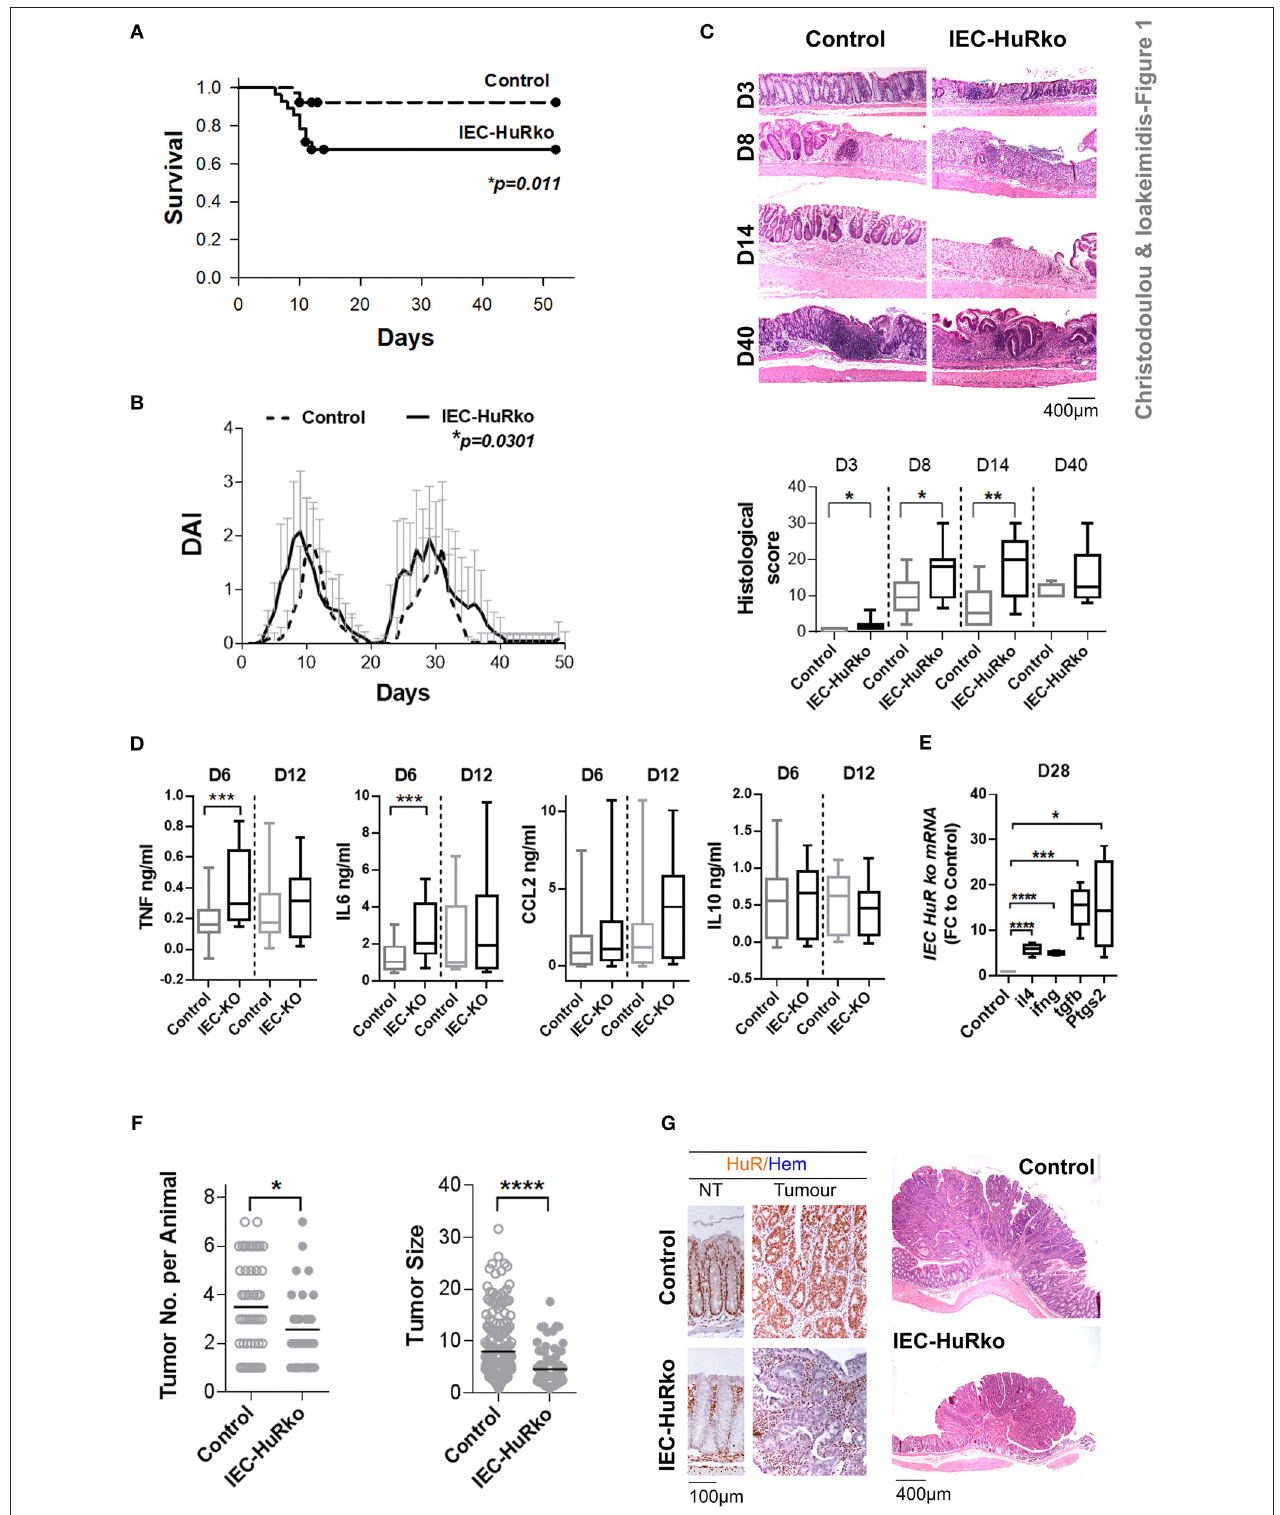
FIGURE 1 | Loss of IEC HuR exacerbates DSS-colitis but attenuates CAC. (A) Kaplan-Meier survival analysis following treatment with two rounds of DSS (Days 0 and 20). n = 30/group. p -value denotes result of Log-rank test. (B) Macroscopic Disease Activity Index (DAI) of the same experimental group as in (A) . Line graphs depict